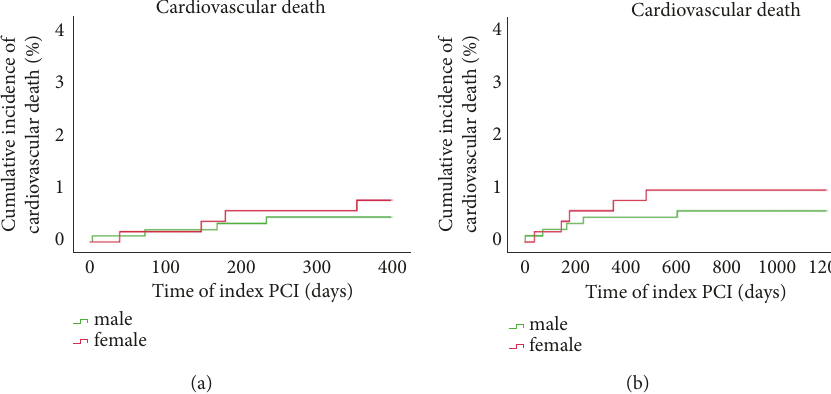
Figure 2: Survival analysis: Kaplan–Meier curves for cardiovascular death at one year (a) and three years (b) comparing males and females with PCAD.